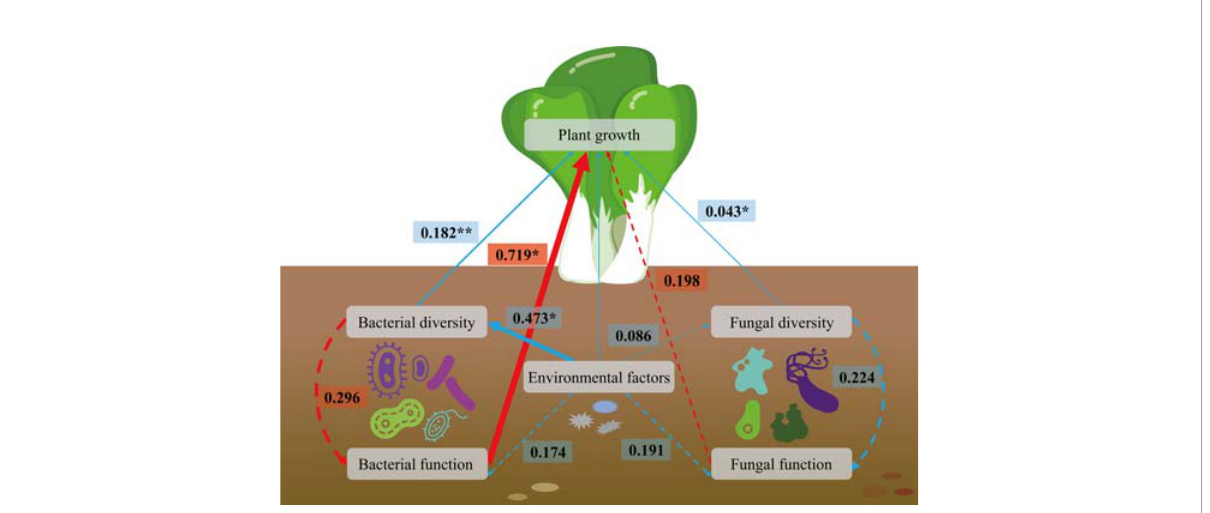
FIGURE 7 Structural equation modeling (SEM) showing the linkage among environmental factors, species diversity, species function, and plant growth. Dotted arrows indicate non-signi fi cant paths ( P > 0.05). Red and blue arrows indicate positive and negative relationships, respectively. The path widths are scaled proportionally to the path coef fi cient. *0.01 < P ≤ 0.05, ** P <